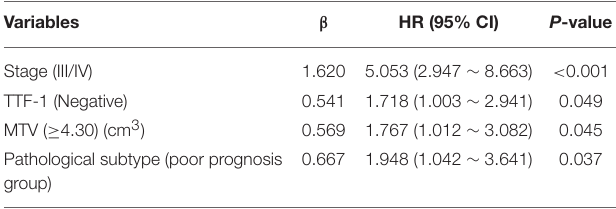
TABLE 6 | The cox proportional hazard regression model for multivariate analysis in patients with invasive lung adenocarcinoma. Variables